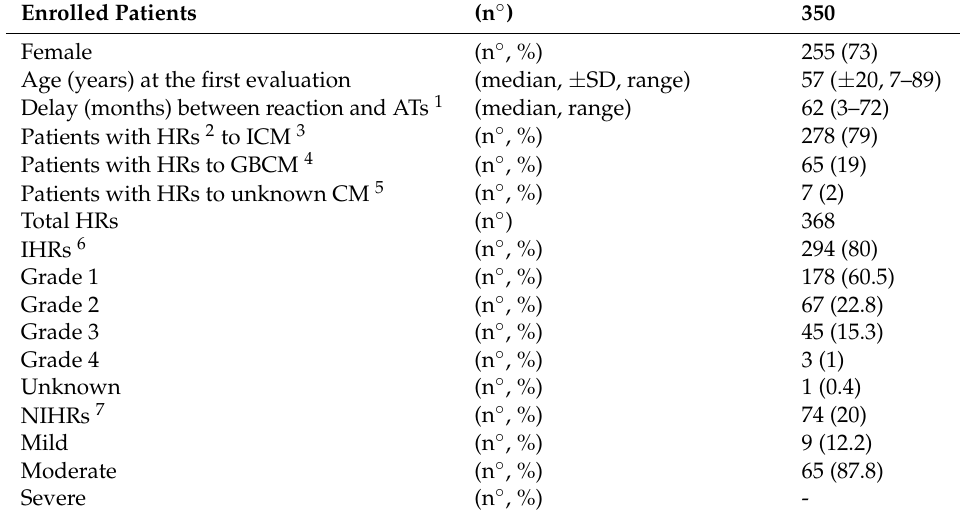
Table 1. Demographic and clinical characteristics.